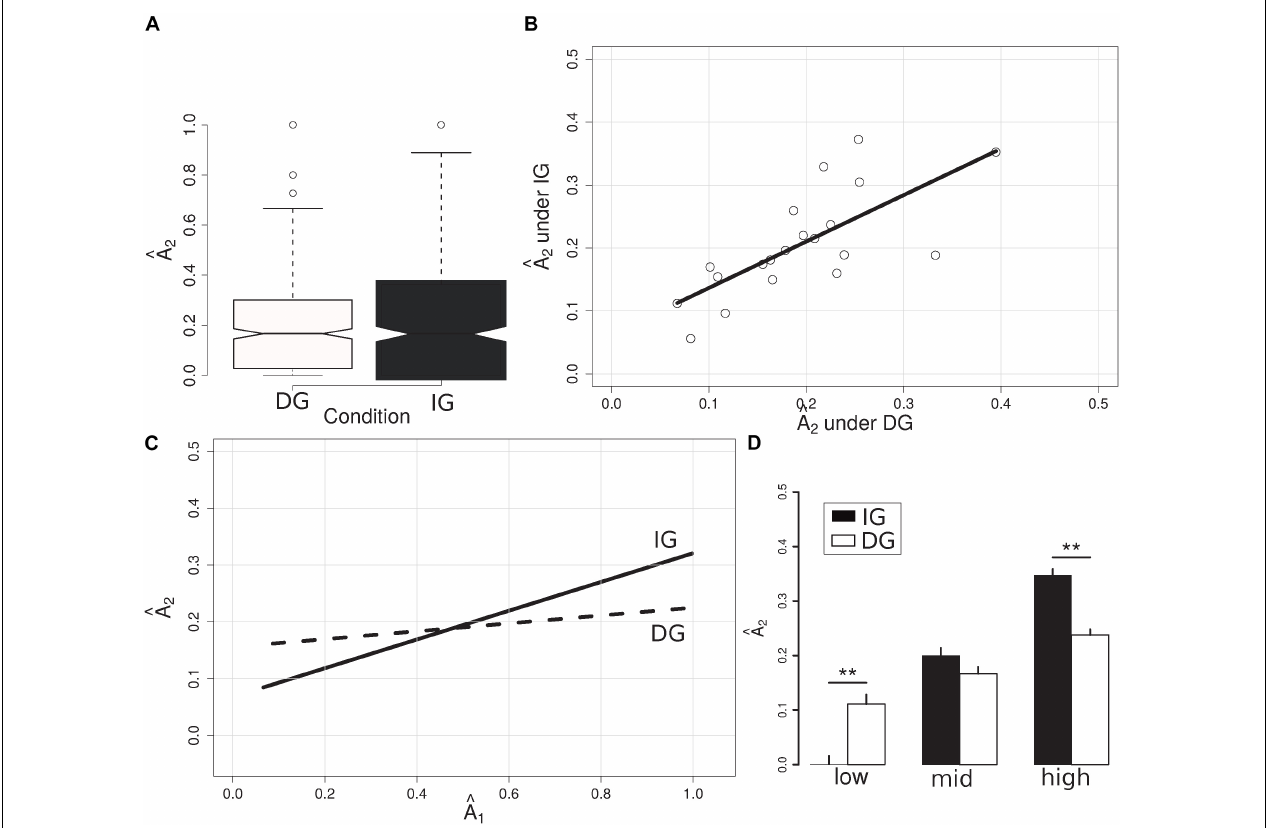
FIGURE 2 | Summary of allocations made under the DG and the IG conditions. (A) Barplot of allocations made under DG (white) and IG (black) conditions. No significant differences were found when we considered the allocations made over the entire range of possible endowments. (B) Scatterplot of mean individual allocations (open circles) under the DG ( X -axis) versus the IG ( Y -axis) conditions; black line corresponds to the Pearson correlation ( r = 0.72; p = 0.0004). Areas of positive and negative reciprocity as a function of the amount received. (C) Participants’ normalized allocations as a function of the normalized amount they received ( X -axis). Lines represent the linear regression of Â 2 on Â 1 (see Equation 1) under IG (solid line) and DG (dashed line) conditions. (D) Bar plot showing the mean allocations made by subjects ( Y -axis) under the IG (black bars) and DG (white bars) conditions, for different levels of received trust ( X -axis); low: Â 1 < 1/3; mid: 1/3 = < Â 1 < 2/3; and high: Â 1 > = 2/3. **indicates p < 0.01.